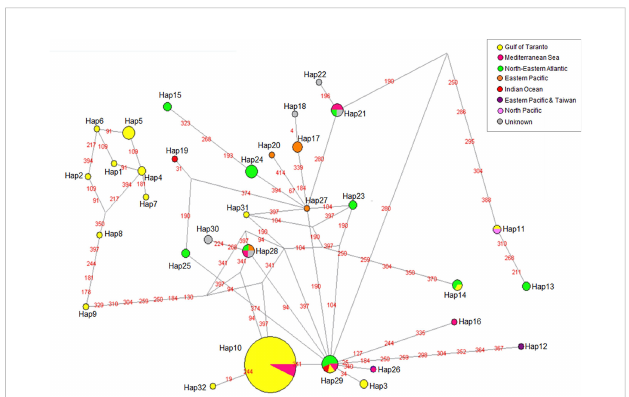
FIGURE 5 Median-joining network of cytb haplotypes of S. coeruleoalba . Haplotype frequency distribution in the considered geographic areas is visualized through pie charts using different color codes (see the graphic legend). For better visualization of the network topology, branch lengths were not maintained proportional to the number of mutations. The latter are indicated by red labels describing the mutated nucleotide position with respect to the fi rst sequence in the dataset